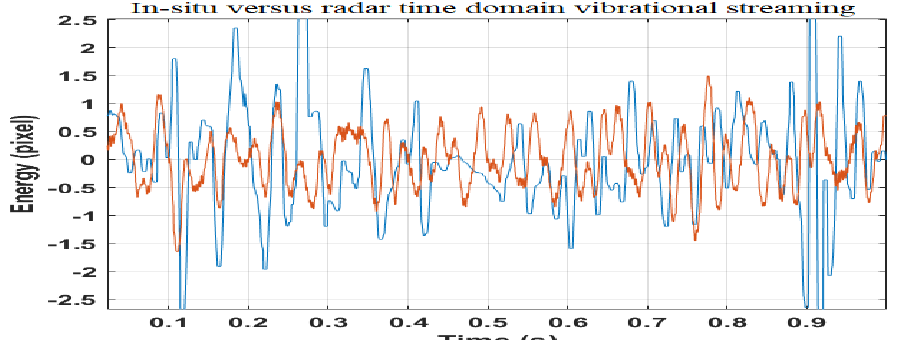
Figure 23. IV-VCRE seismograph station versus SAR synchronized time-domain vibrational streaming.